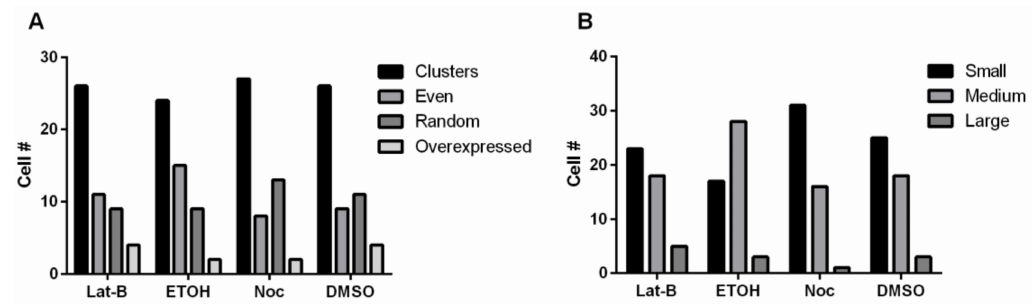
Figure 5. Analysis of mitochondrial distribution and size when treated with Lat-B or Noc. Disruption of the cytoskeleton does not alter ( A ) distribution or ( B ) size of the mitochondria when FszB-GFP is overexpressed. n = 50